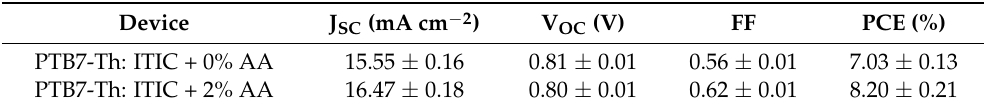
Table 1. Device Characteristics of PTB7-Th: ITIC with and without the AA additive. The averages were based on 6 inverted devices with a defined device area of 0.1 cm 2 .